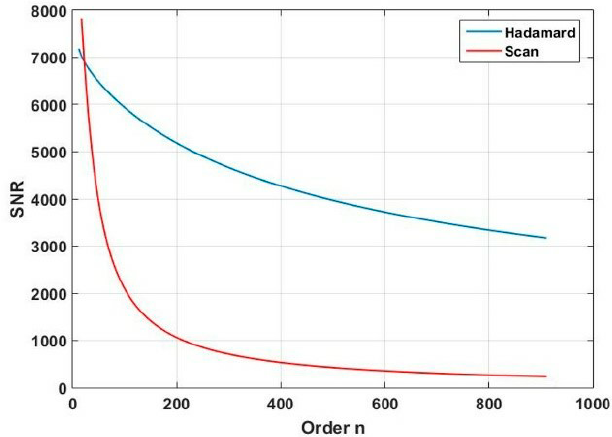
Figure 9. SNR of two scan methods for stable light source.